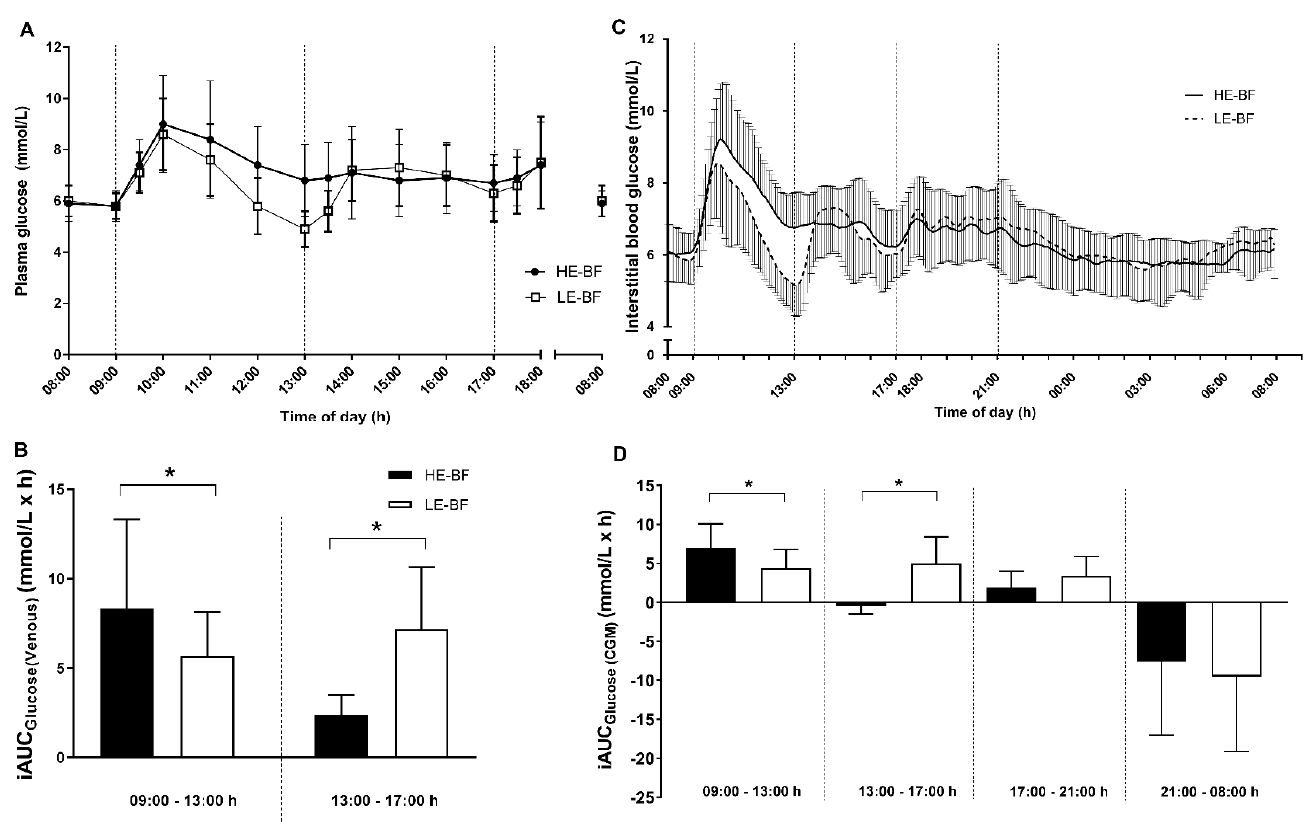
Figure 3. Venous glucose concentrations ( A ) from 1 h pre-breakfast (08:00) until 1 h post-dinner (18:00), for participants with prediabetes ( n = 13) throughout trial conditions (high-energy breakfast (HE-BF; black bars and symbols) and low-energy breakfast (LE-BF; white bars and symbols)), and venous incremental area under the curve (iAUC) ( B ) for 4 h meal periods (09:00–13:00 h; 13:00–17:00 h); Interstitial (CGMS) glucose ( C ) values from one hour pre-breakfast (08:00) until 08:00 the following morning, and CGM iAUC ( D ) for 4 h meal periods (09:00–13:00 h; 13:00–17:00 h; 17:00–21:00 h) and overnight (21:00–08:00 h). Meals were ingested at 09:00, 13:00 and 17:00 h on both condition days. Vertical lines represent the 4 h iAUC analysis periods. Data are mean ± SD. From LMM analyses, significantly different * between groups ( p < 0.05).